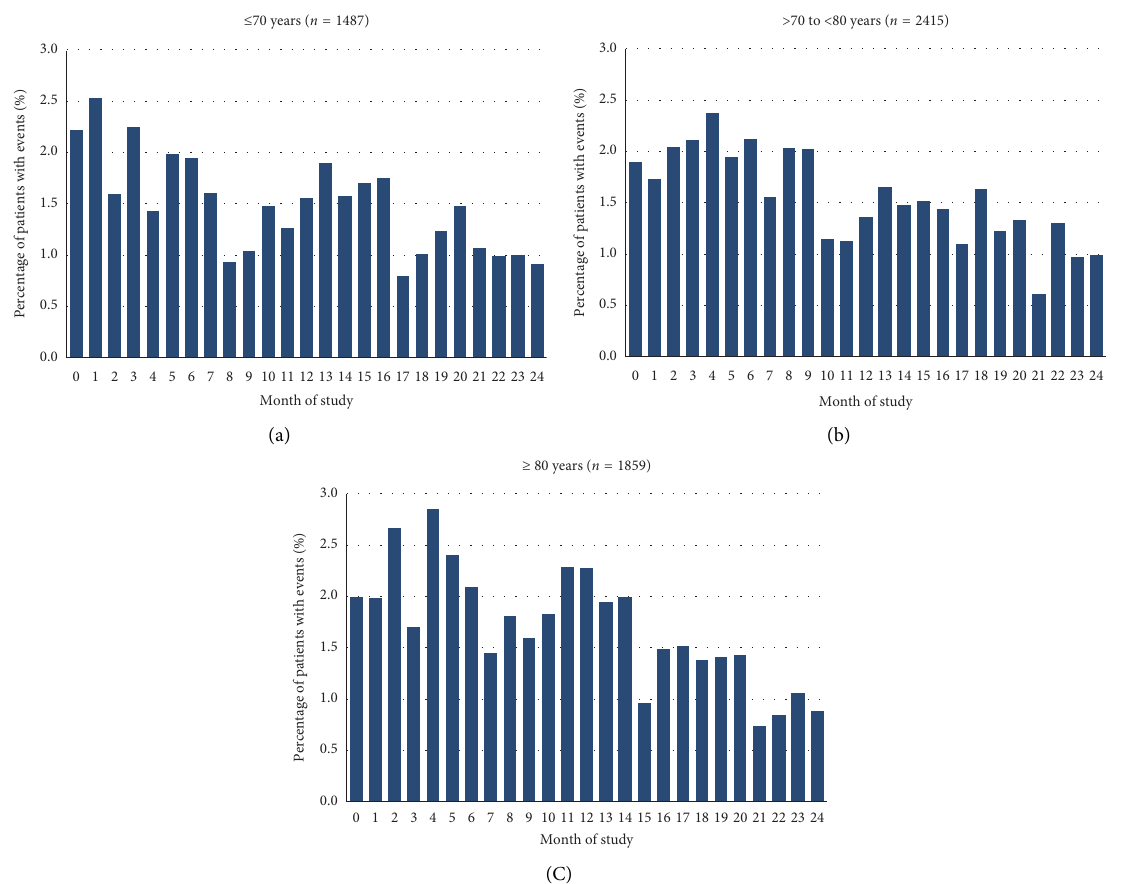
Figure 4: Incidence rates of adverse event for each month of the study, by age group. No consistent impact of the patients’ age on the overall incidence rate of AEs was observed. Calculation of percentages was based on number of patients not discontinued in the respective month. Patients with multiple adverse events within one month were counted only